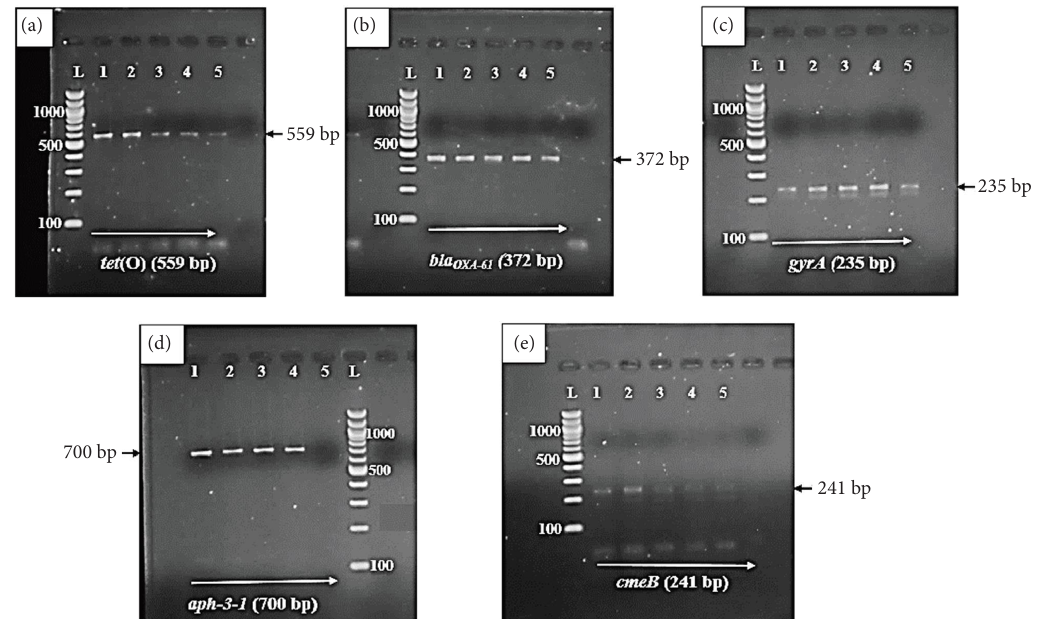
Figure 3: Exemplar of agarose gel electrophoresis of antimicrobial resistance genes: (L) 100bp ladder/marker; 559 base pair (bp) tet (O) (a); 372bp bla OXA-61 (b); 235bp gyrA (c); 700 bp aph -3-1 (d); and 241 bp cmeB (e).